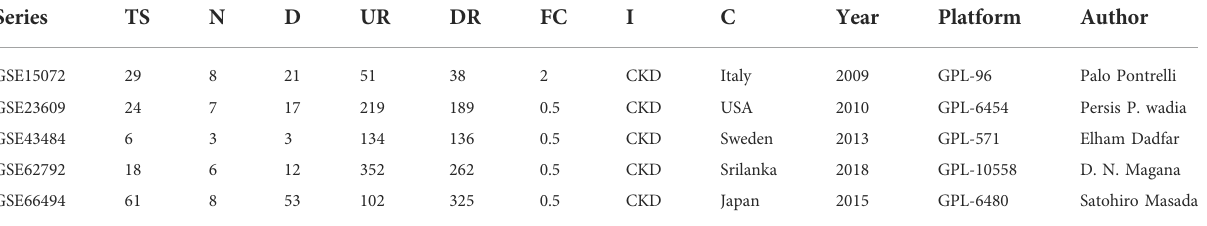
TABLE 1 The details of the present analysis GSE